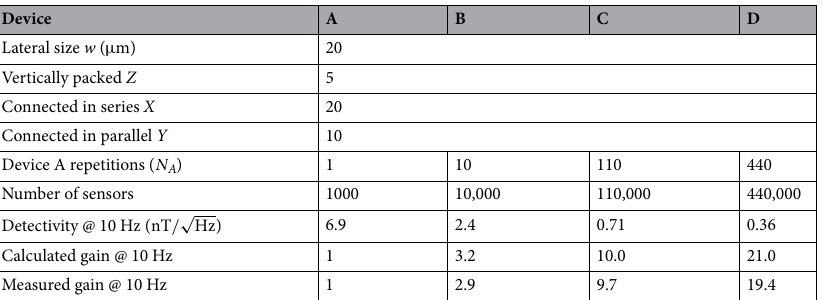
Table 2. Details of the characterized vertically-packed 2D arrays. Z is the number of vertical spin-valves, X connected in series and Y in parallel. Sensor A represents an array of X = 20 , Y = 10 and Z = 5 with a total number of 1000 sensors. Sensor B, C and D are the array A replicated 10,110 and 440 times, respectively. The detectivity gains, calculated and measured, are obtained relative to Device